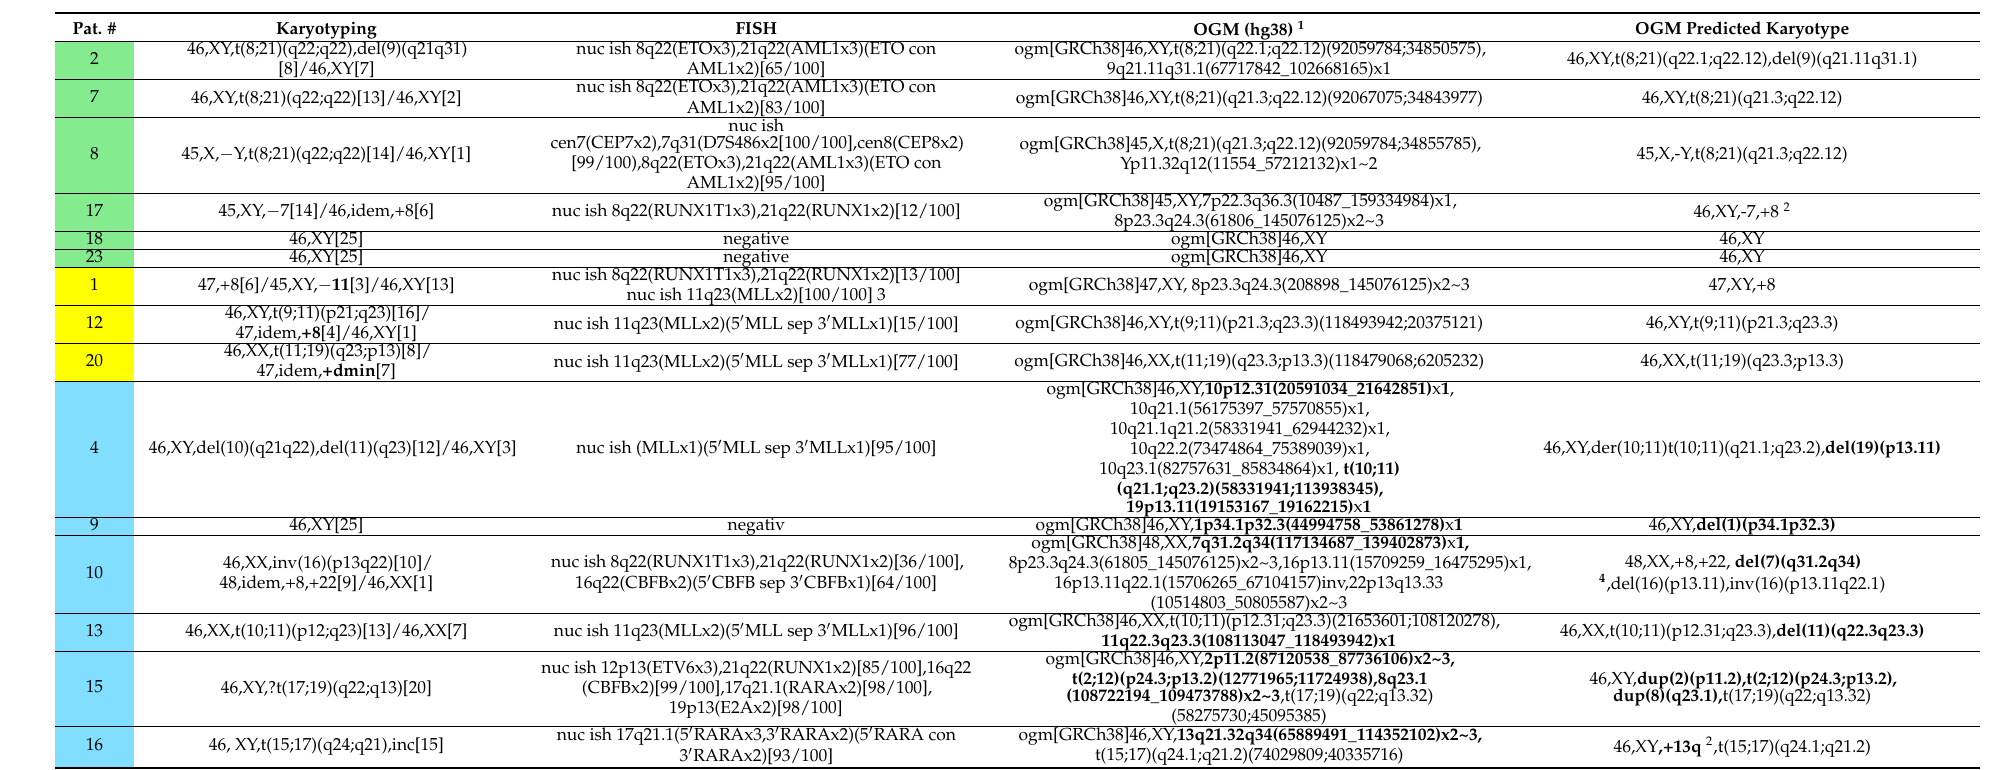
Table 2. Comparison of karyotyping and FISH versus